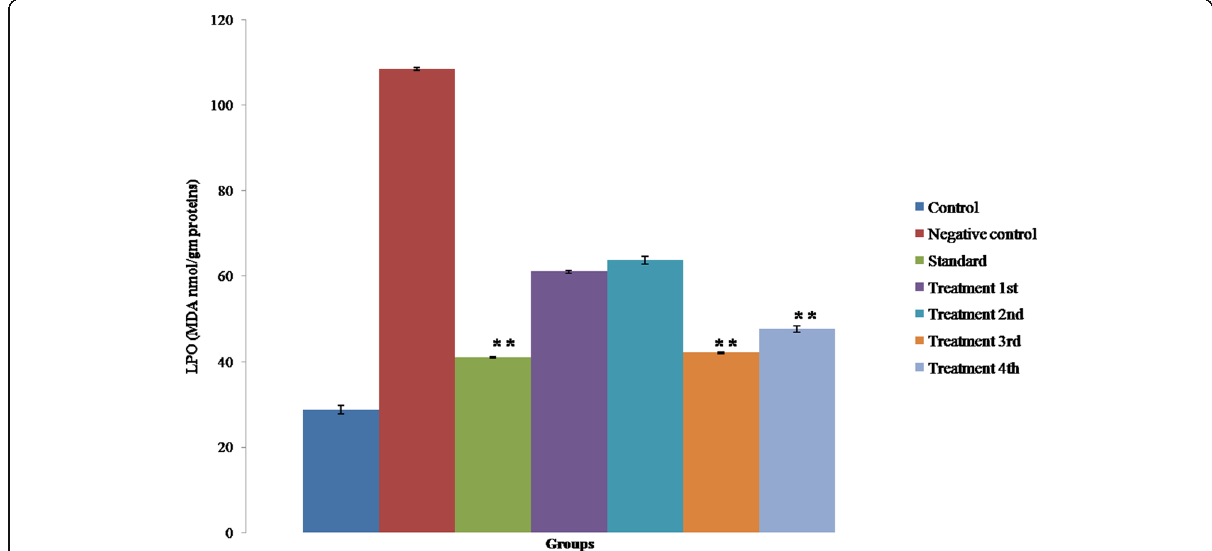
Fig. 10 Effects of PH extracts on LPO activity. Results are Mean ± S.E.M, n = 6 animals in each group. ANOVA, Dunnett ’ s test ** p < 0.001 compared with arthritic control